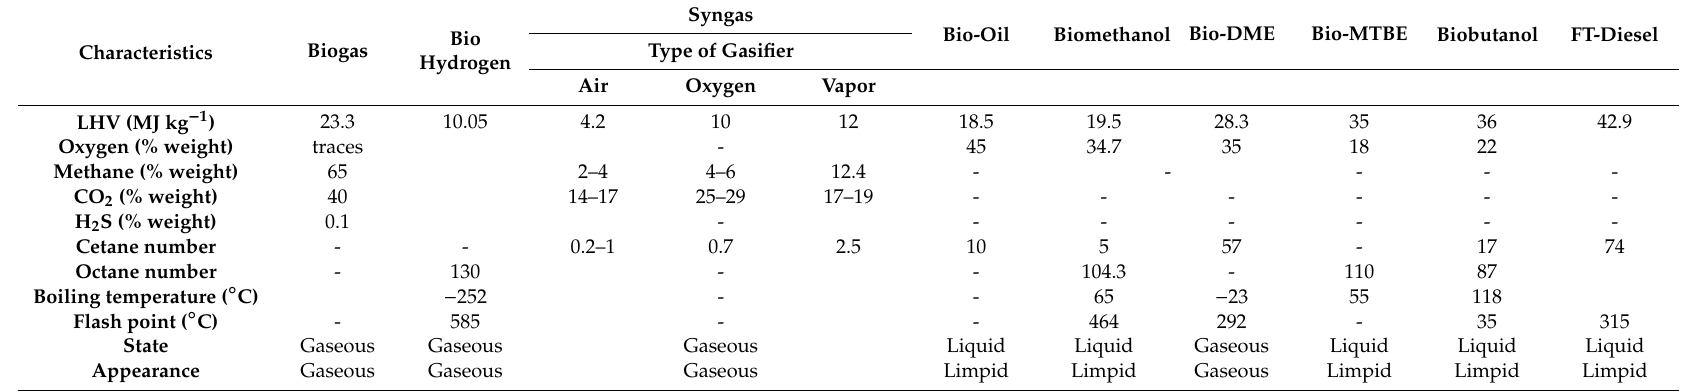
Table 2. Physico-chemical characteristics of second-generation biofuels (modified from [11] LHV: lower heating value; Bio-DME: biodimethyl ether; Bio-MTBE: biomethyl tert-butyl ether; FT-Diesel: Fischer–Tropsch